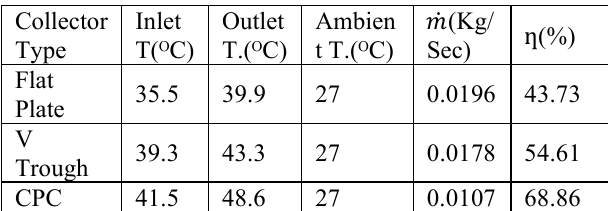
Table 2. Comparative Analysis of Flat Plate, V- Trough and Compound Parabolic